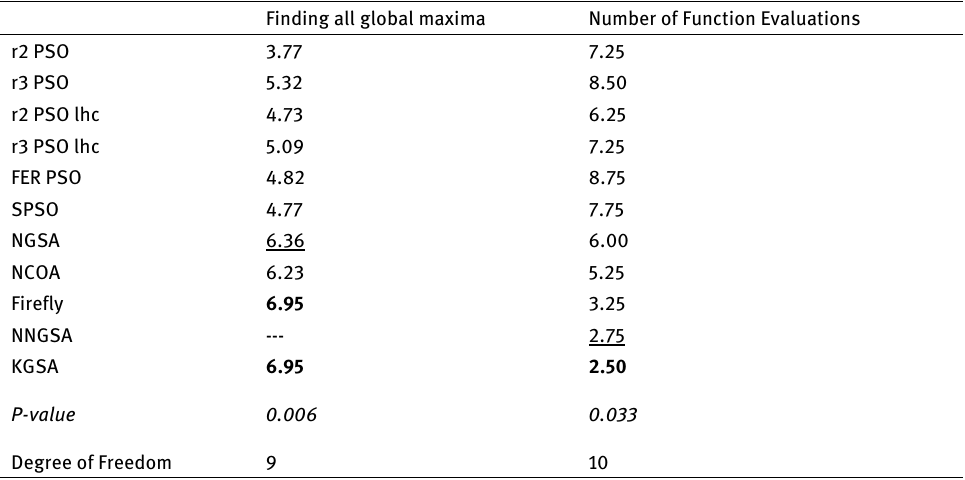
Table 11: Friedman test on KGSA and the other algorithms Finding all global maxima Number of Function Evaluations r2 PSO 3.77